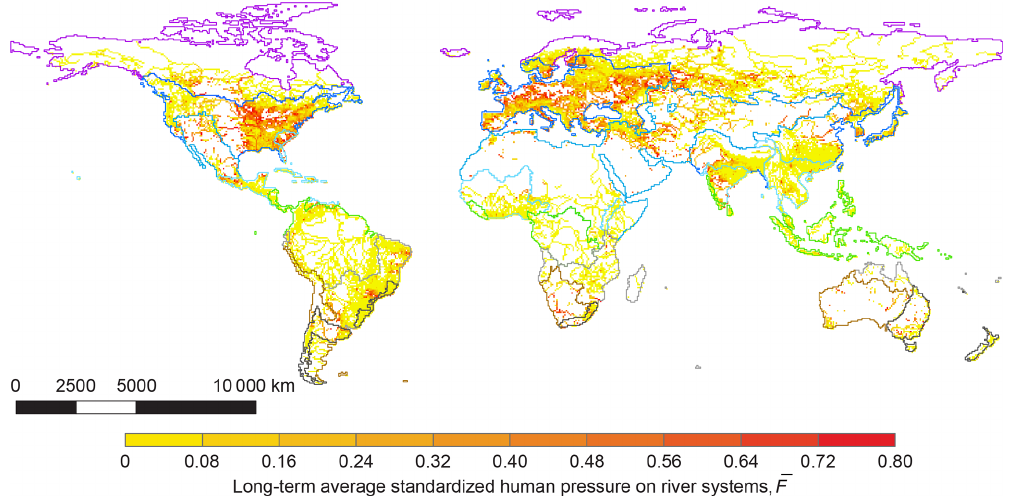
Figure 2. Global distribution of long-term average standardized human pressure on river systems, F . Colors differentiate grid cells (20770 in total) according to levels of F . Hydrobelt boundaries (Meybeck et al., 2013) are also shown (i.e., boreal in purple, northern midlatitude in dark blue, northern dry in cobalt, northern subtropical in light blue, equatorial in green, southern subtropical in grey, southern dry in brown, southern midlatitude belt in